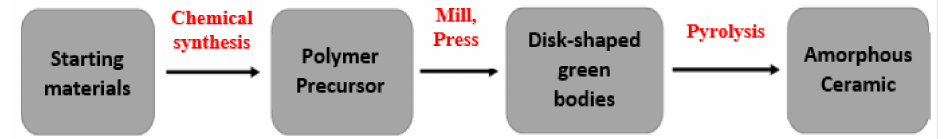
Figure 1. Processing steps for synthesizing PDC (SiCN)